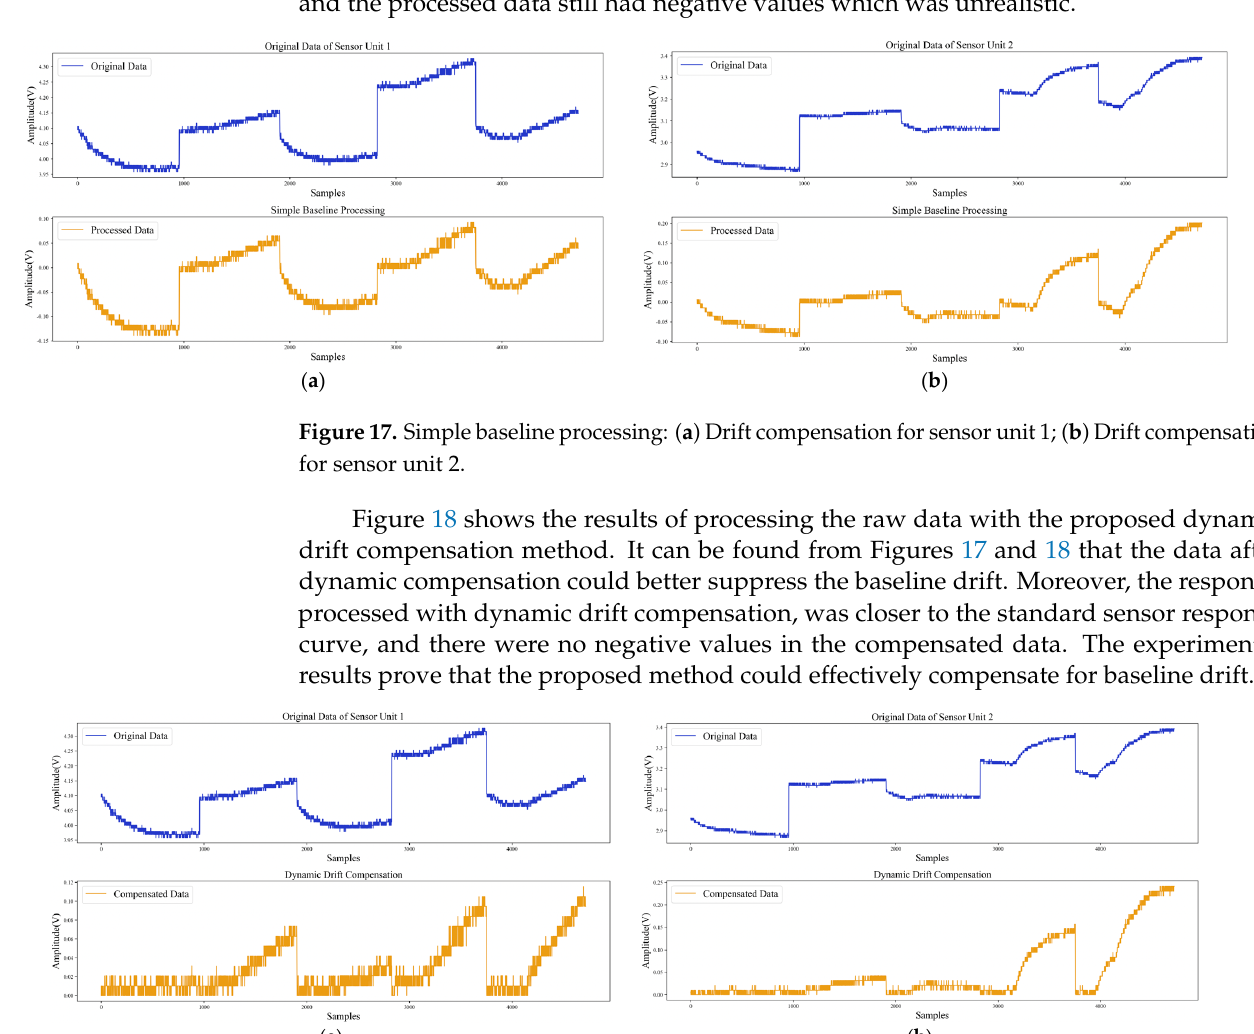
Figure 18. Dynamic drift compensation: ( a ) Drift compensation for sensor unit 1; ( b ) Drift compensation for sensor unit 2.